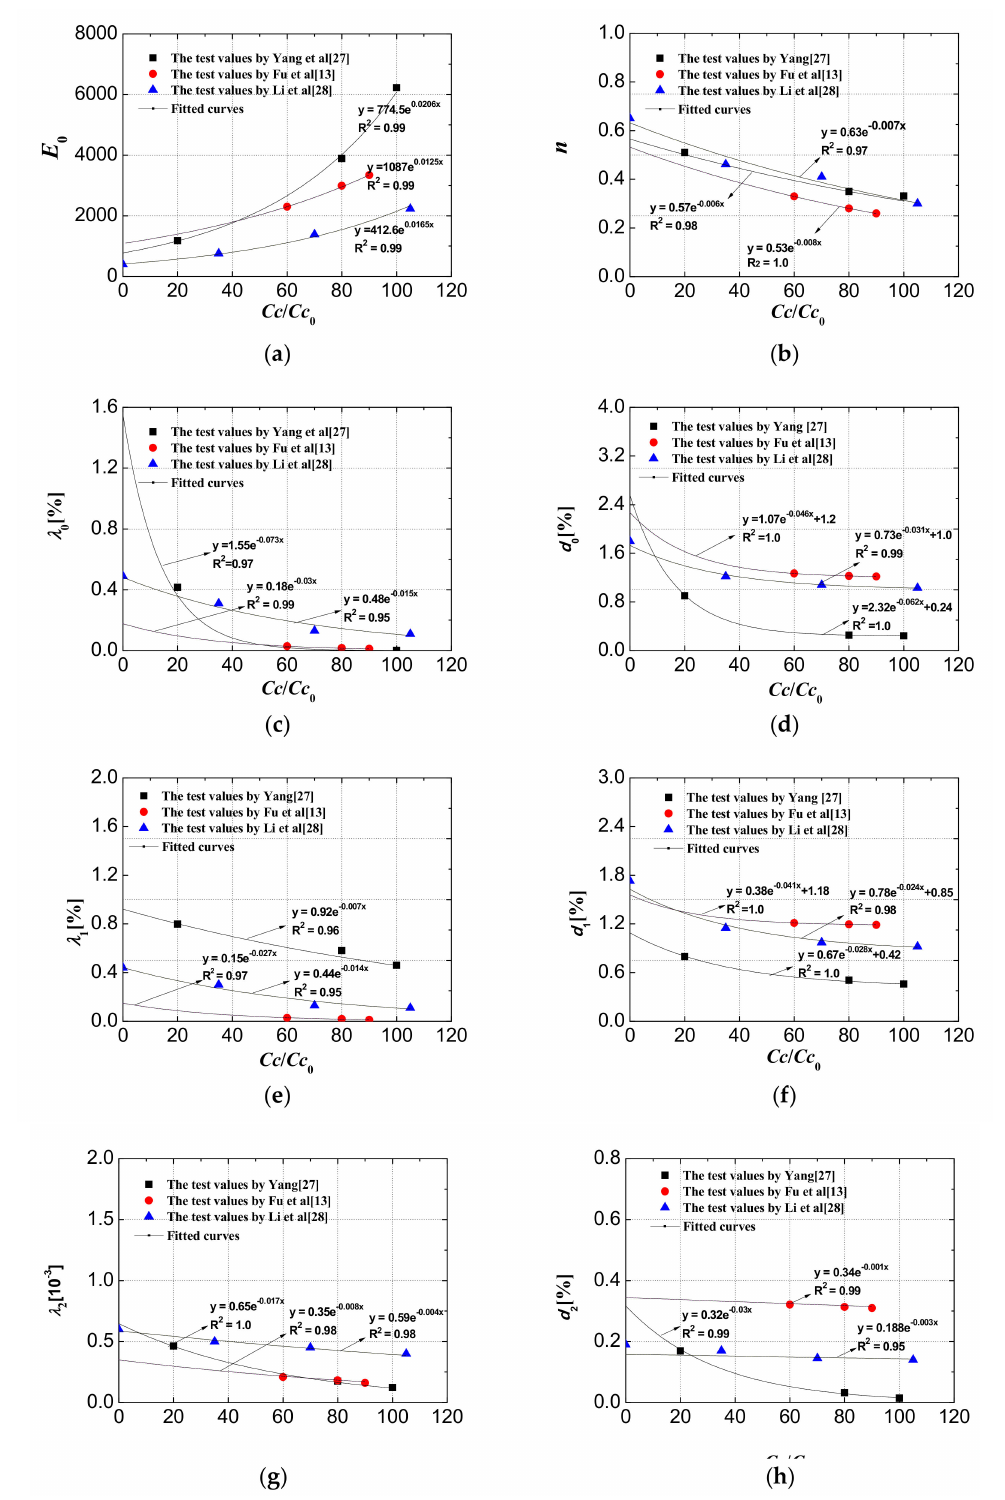
Figure 16. The relationship between the parameters and the cement content Cc : ( a ) E 0 ; ( b ) n ; ( c ) λ 0 ; ( d ) d 0 ; ( e ) λ 1 ; ( f ) d 1 ; ( g ) λ 2 ; ( h ) d 2